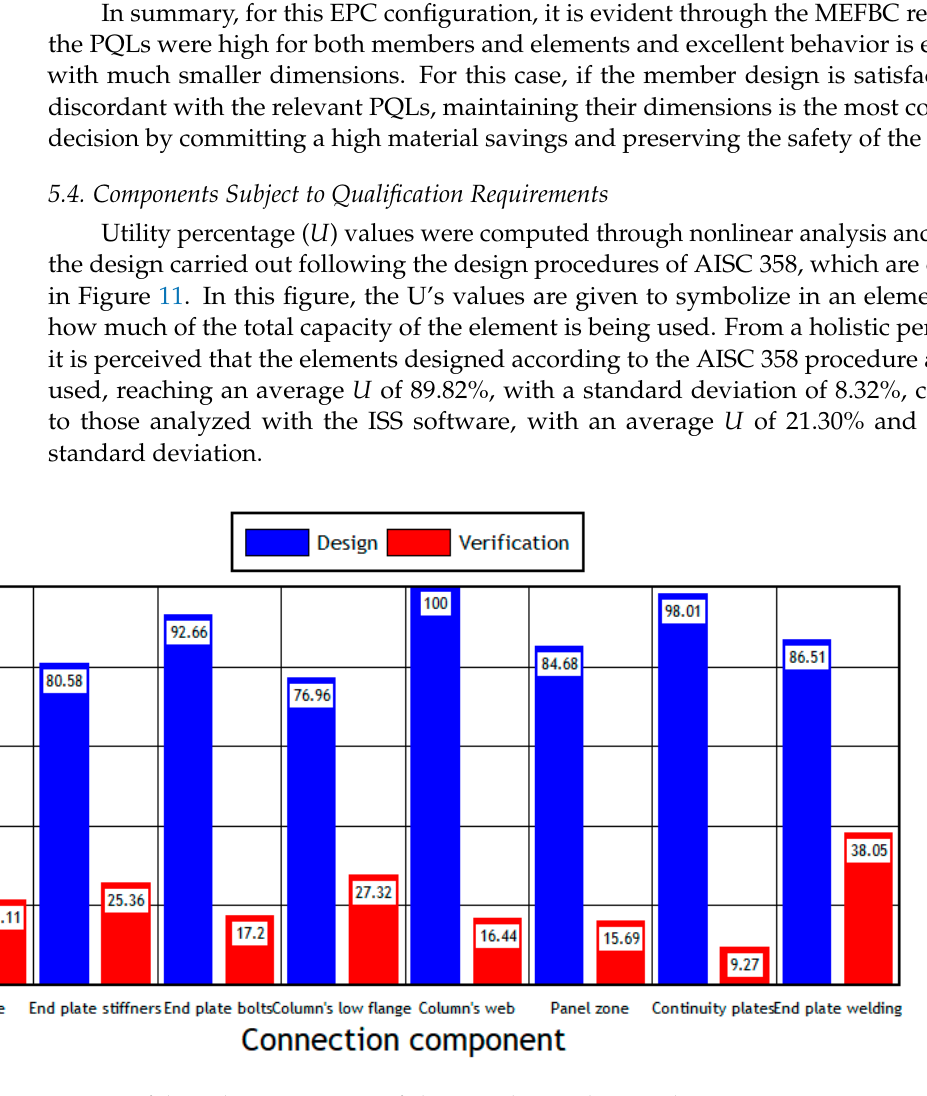
Figure 11. Comparison of the utility percentages of elements designed vs. nonlinear assessment.